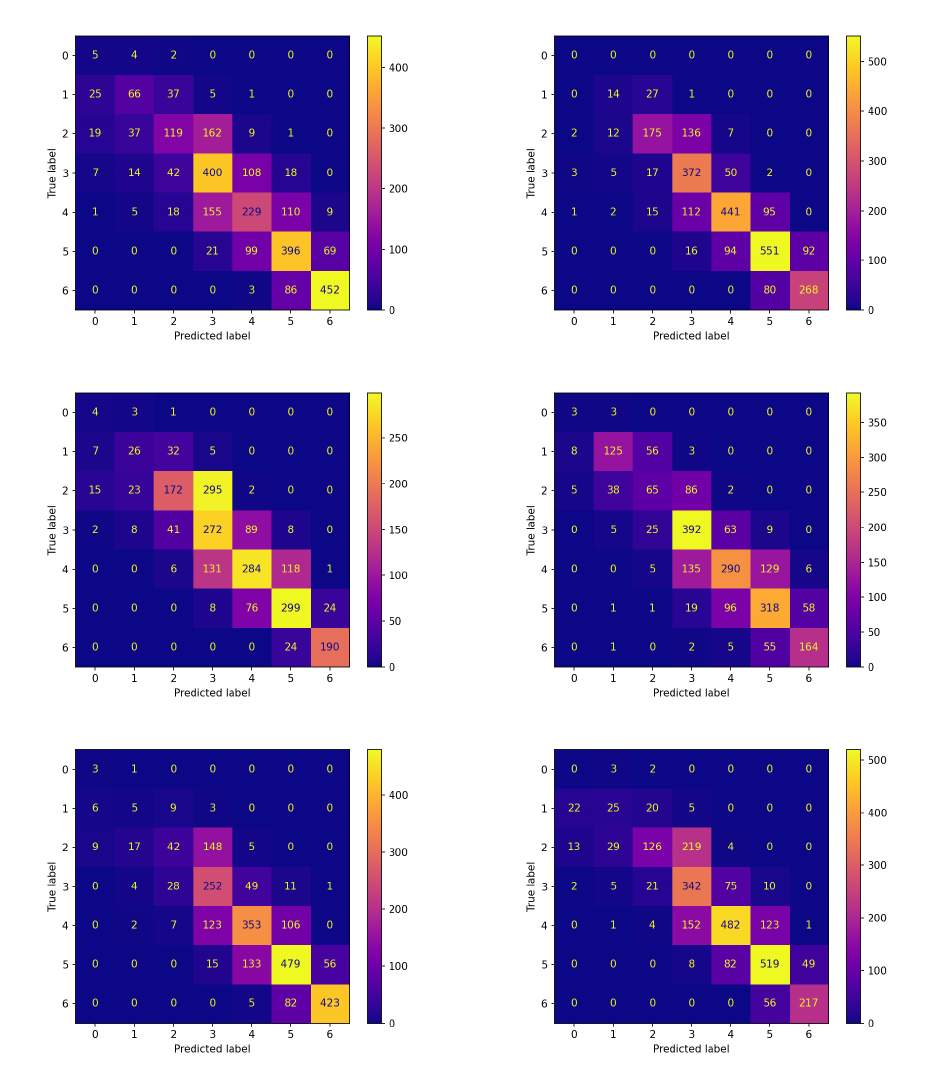
Figure 6. Confusion matrices on the testing set of new subjects not participating in the learning process achieved by the best model (model 570) evolved by non-FL